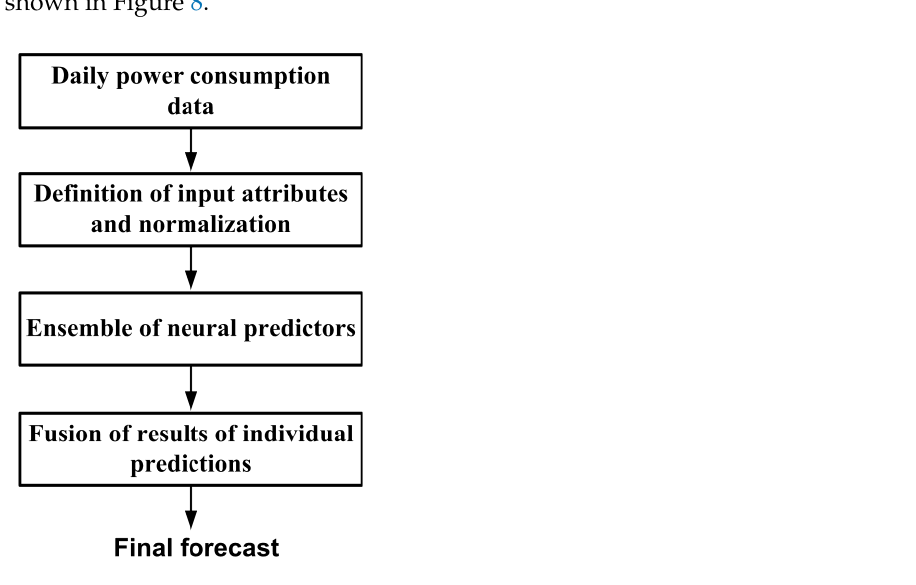
Figure 8. The flowchart of signal processing leads to the final forecast of the load pattern.